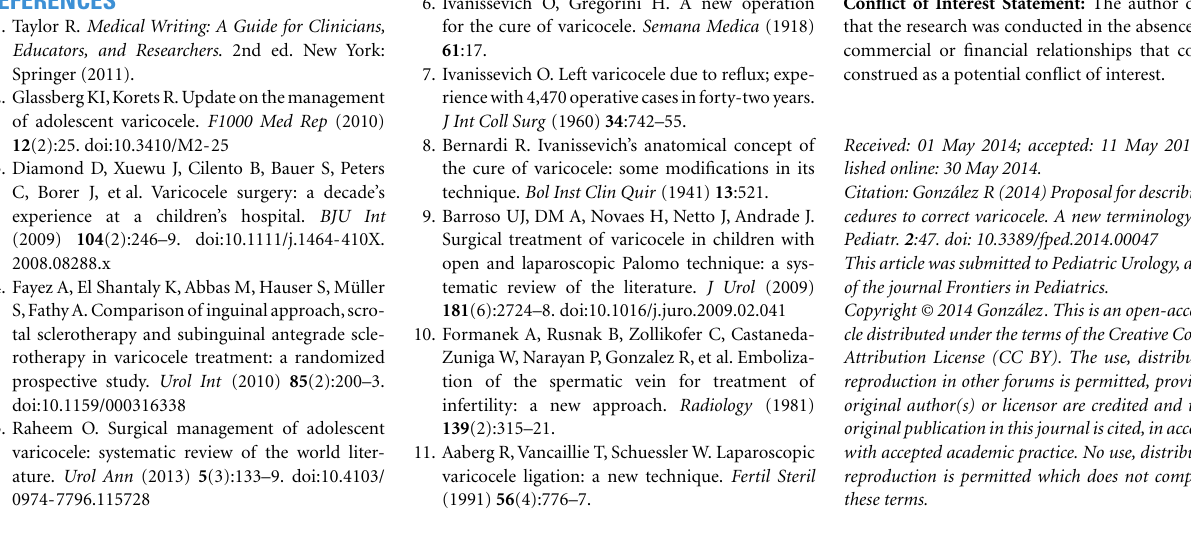
FIGURE 1 |The figure from Ivanissevich’s 1960 paper (7) clearly shows that the incision (first described in the 1918 paper) is medial to the anterior superior iliac spine, thus a suprainguinal or retroperitoneal approach (presented at the 24thAnnual Congress of the European Society for Paediatric Urology, Genoa, Italy) .With permission from International College of